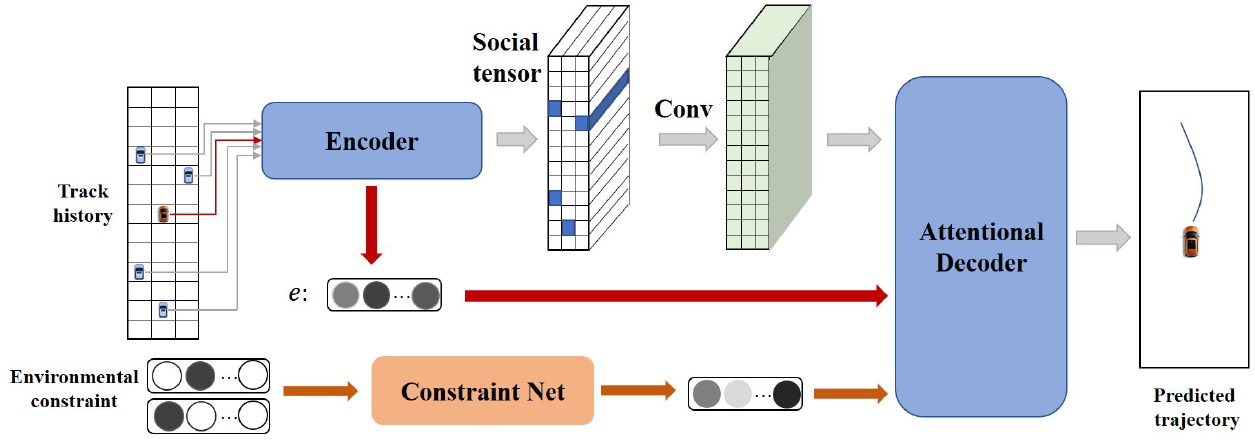
Figure 1. Architecture of the proposed dynamic and static context-aware attention network (DSCAN). Track history and environmental constraint are considered by the modules, and the attentional decoder uses the concatenated representation to predict the vehicle’s